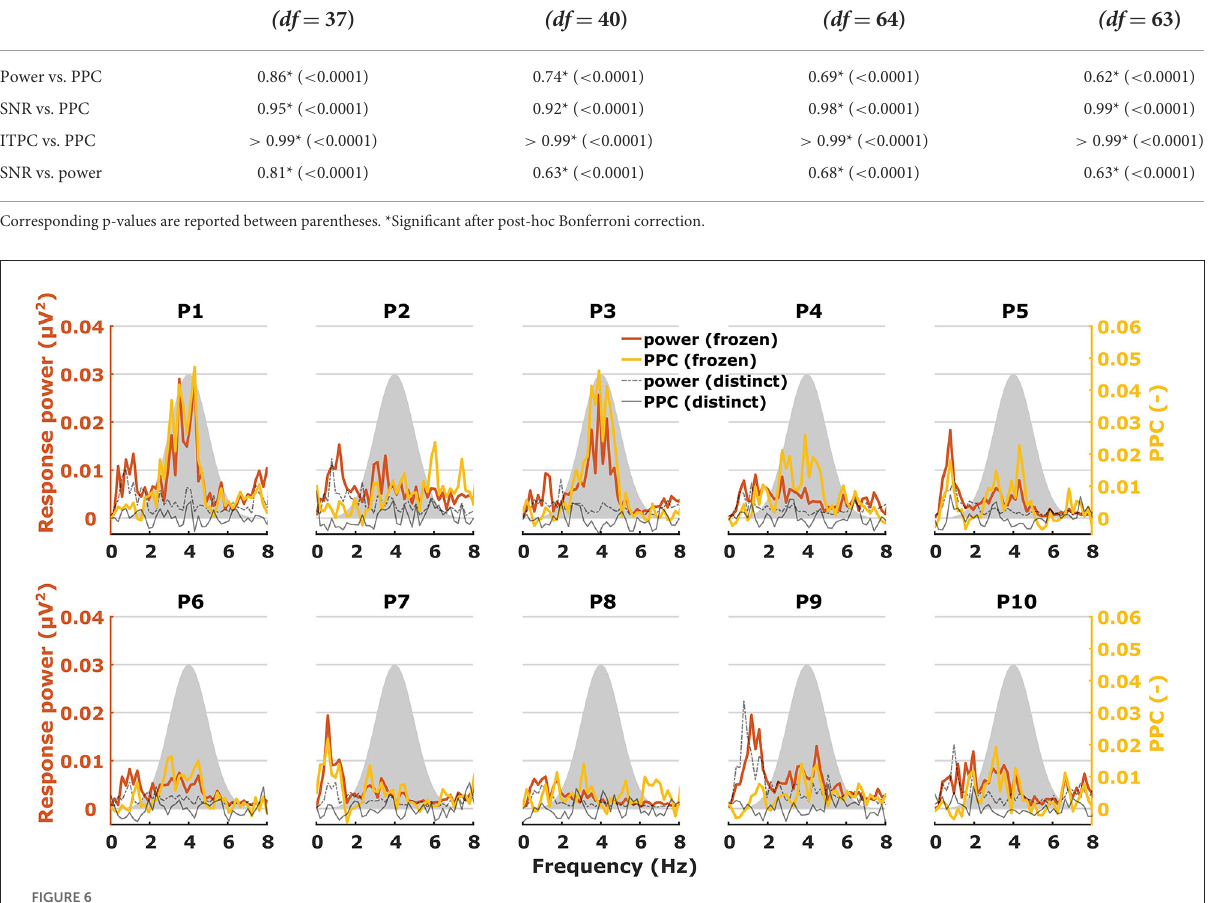
TABLE 1 Pearson’s correlation coefficients between different electrophysiological metrics of syllabic-like and phonemic-like ASSRs in the left and right hemispheric channels. Syllabic-like Phonemic-like Left Right Left Right